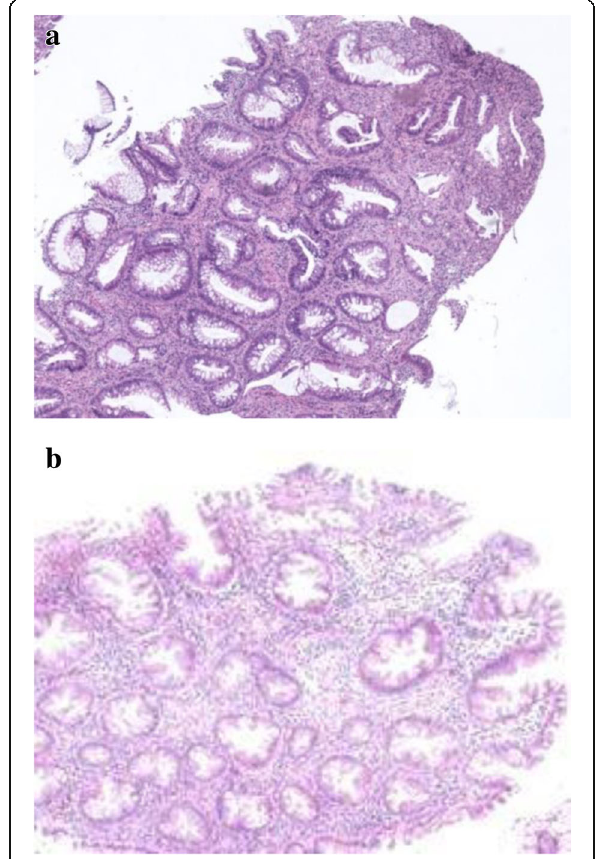
Fig. 2 Histopathological sections of biopsy specimens revealed mild adenomatous glands (A) and serrated glands with no atypia that